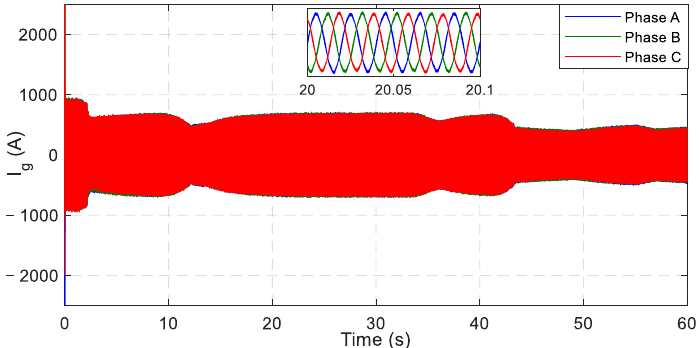
Figure 21. Grid currents of WECS with PI controller.